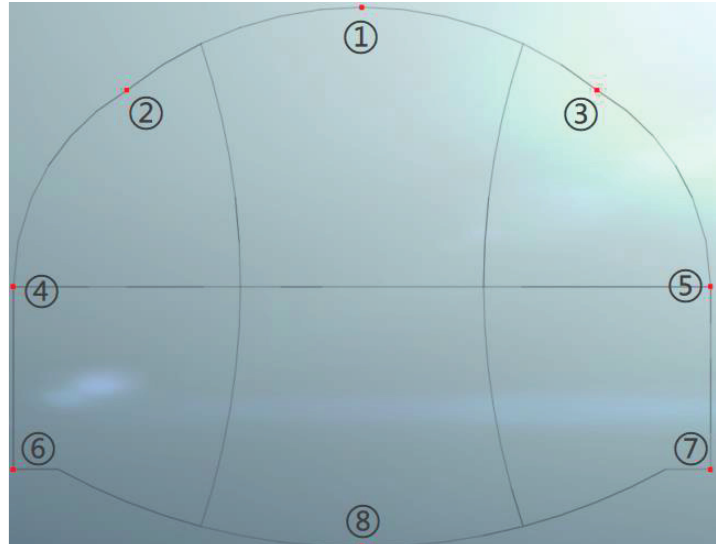
Figure 6: Layout diagram of initial support monitoring points.